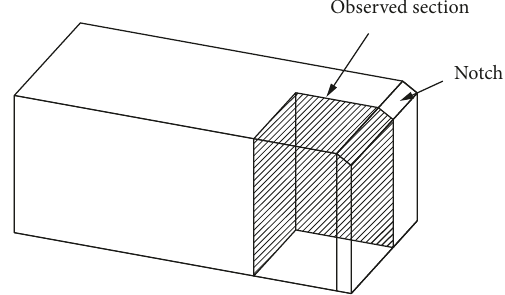
Figure 6: TEM observation of CTOD near-fracture